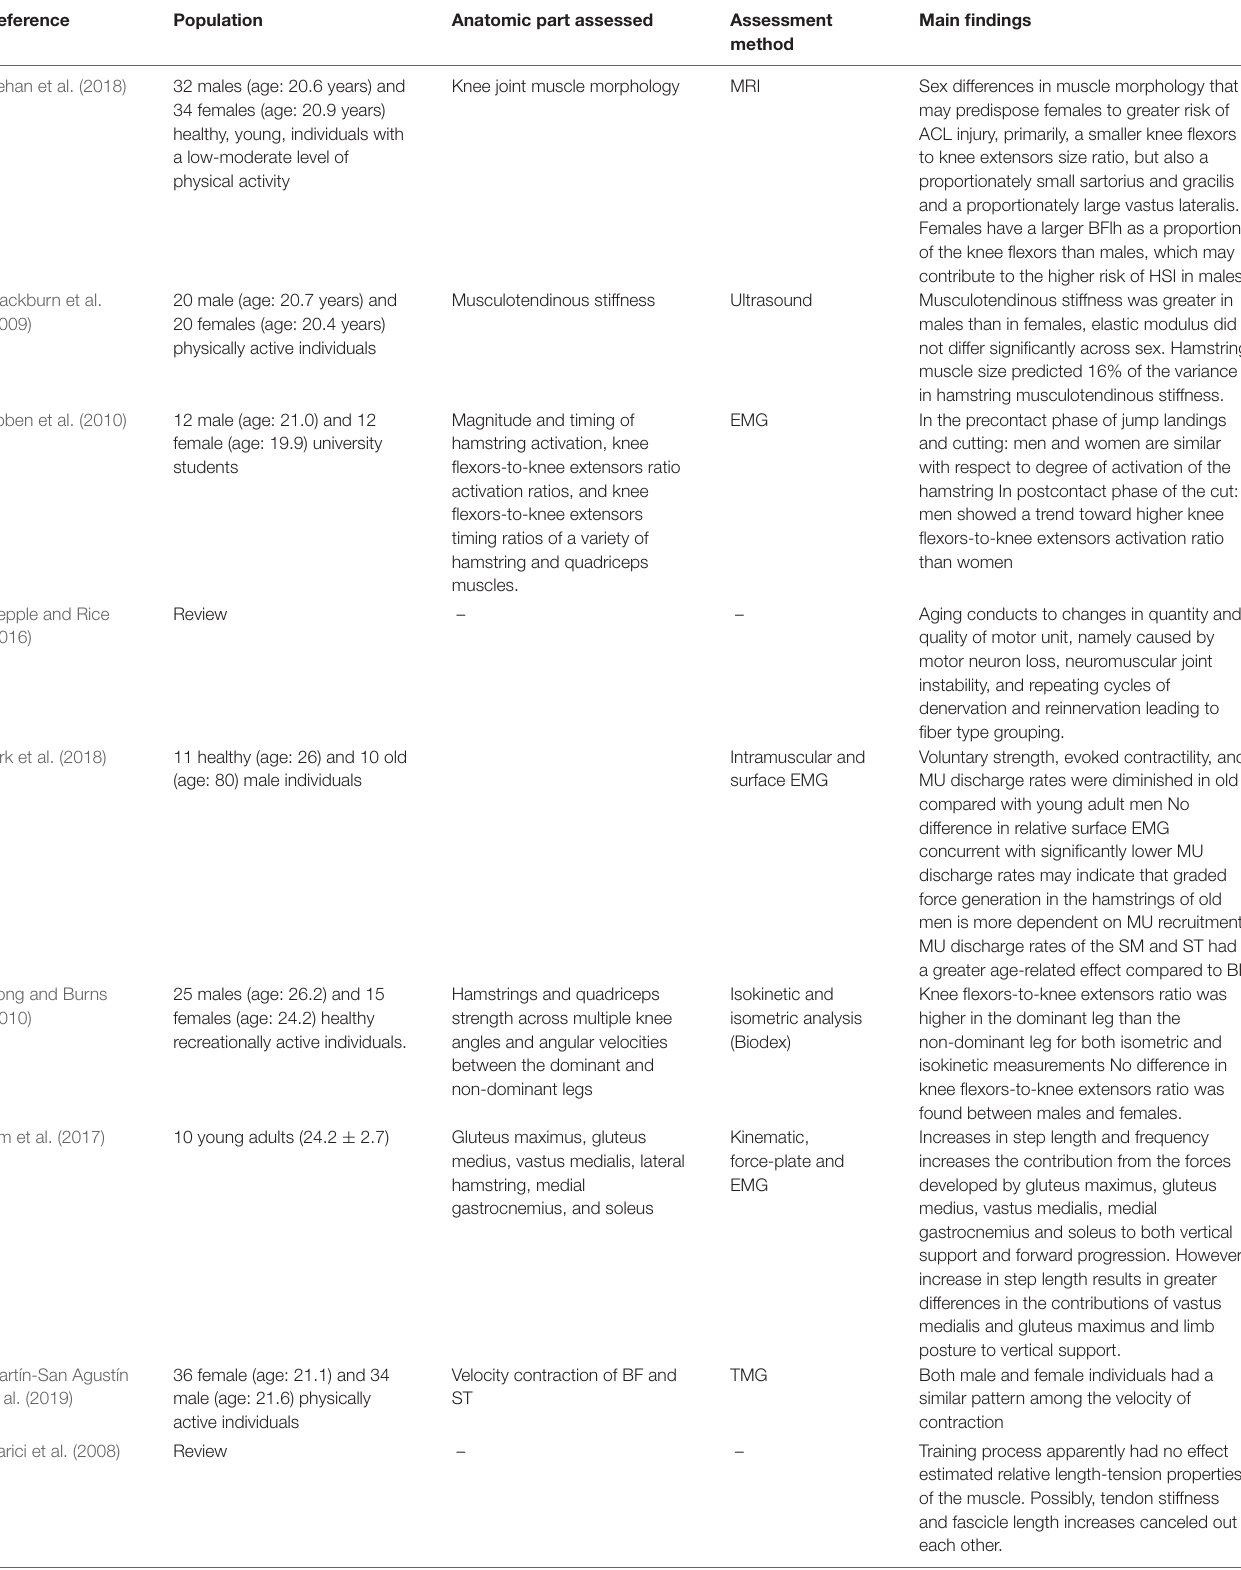
TABLE 2 | Summary of studies cited in Section “Sex- and Age-Related Differences in Hamstrings’ Anatomy and